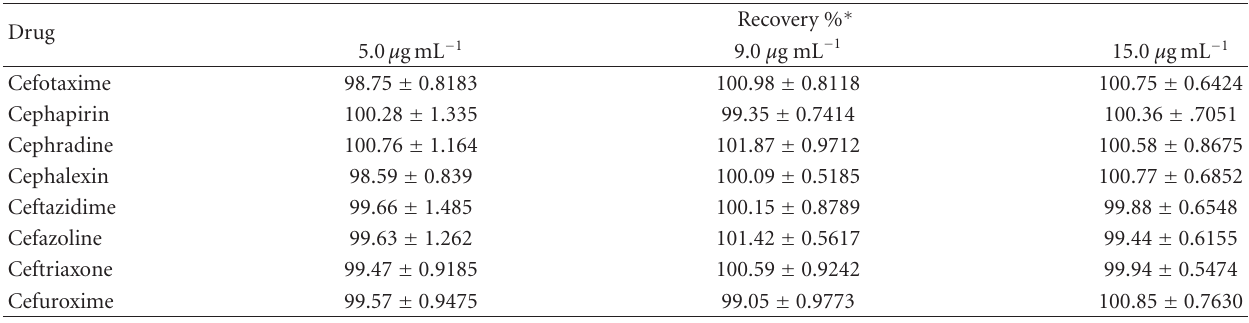
Table 5: Evaluation of accuracy of the analytical procedure using fixed time method.